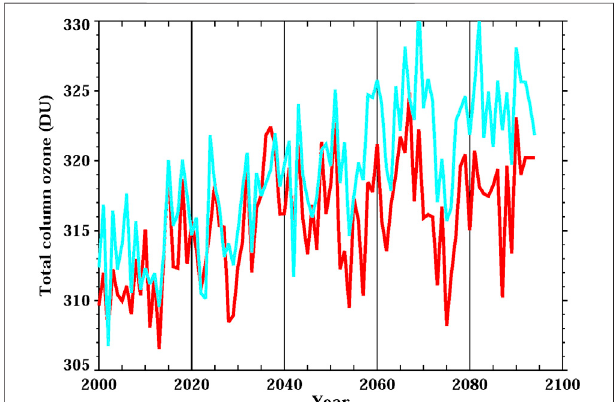
FIGURE 10 | Evolution of the northern hemisphere mean TCO obtained from the model SOCOLv4 (red line) and retrieved from proxies with Arosa/ Davos TCO as an additional proxy (light blue line). The correlation coef fi cient between reconstruction and the model SOCOLv4 is